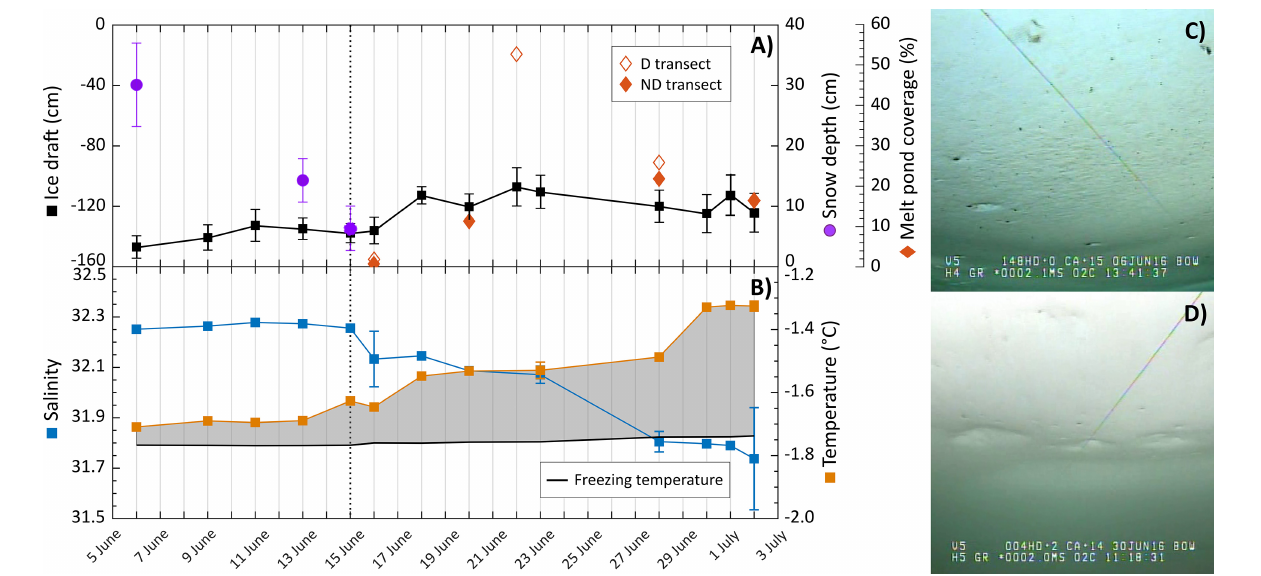
FIGURE 4 | Time series of spatially averaged (A) snow depth (purple circles, standard deviation error bars), ice draft (black squares), melt pond coverage (red diamonds), and averaged (B) surface water salinity (blue squares), surface water temperature (orange squares), and freezing temperature of seawater for each transect at 2.4-m depth over the sampling period. Images of the ice bottom were taken at 2 m on (C) 6 June, and (D) 30 June 2016. Melt pond coverage for the transect area is highlighted for D transects (empty diamonds) and ND transect (filled diamonds) after the melt pond onset (dotted line). The shaded area highlights the difference between water and freezing